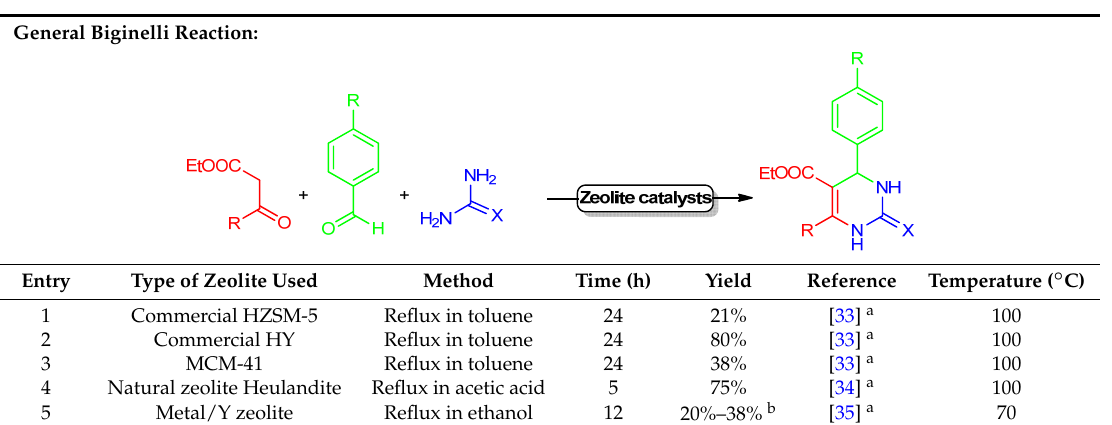
Table 1. Utilization of zeolite catalysts for Biginelli reaction in last two decades.